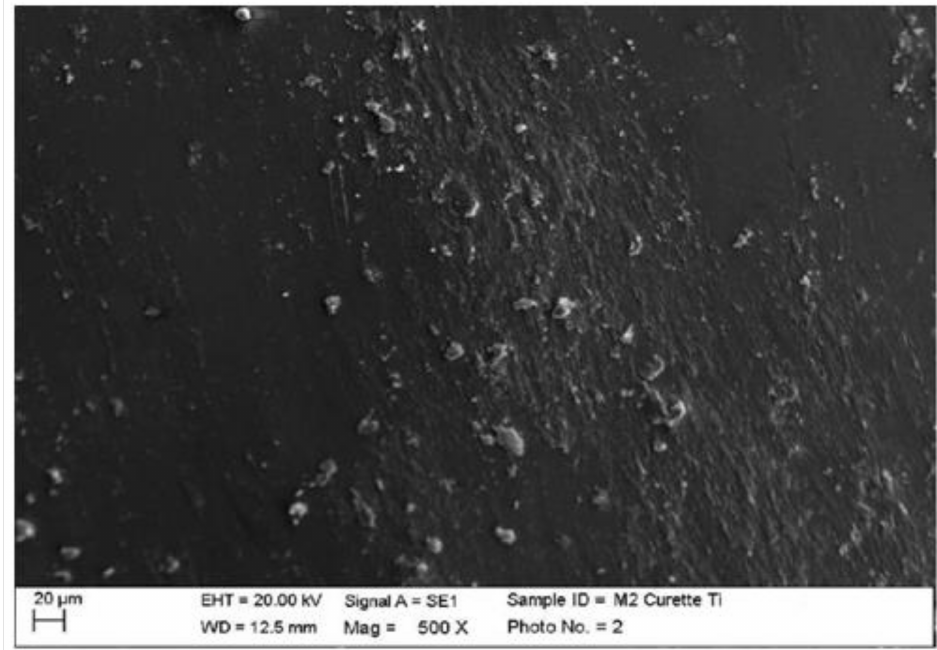
Figure 17. Instrumented ceramic sample M2 with titanium curette (500 ×